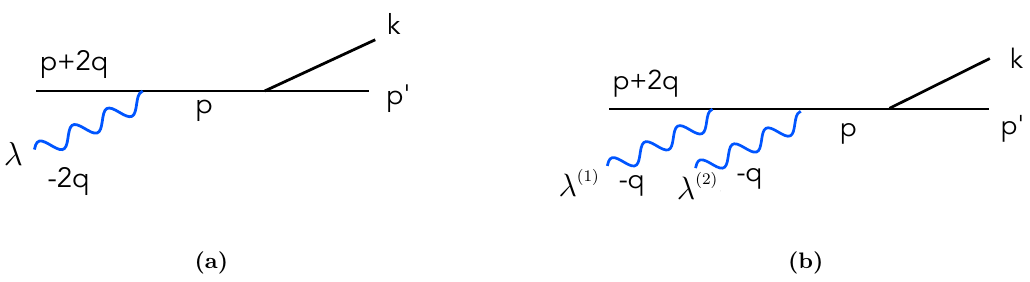
Figure 3. (a) We extract the scattering amplitude involving an excited string in the state λ · A − 2 | 0 i from an amplitude involving a “DDF photon” of momentum − 2 q . (b) We extract the scattering amplitude involving an excited string in the state λ (1) · A − 1 λ (2) · A − 1 | 0 i from an amplitude involving two “DDF photons”, each of momentum − q